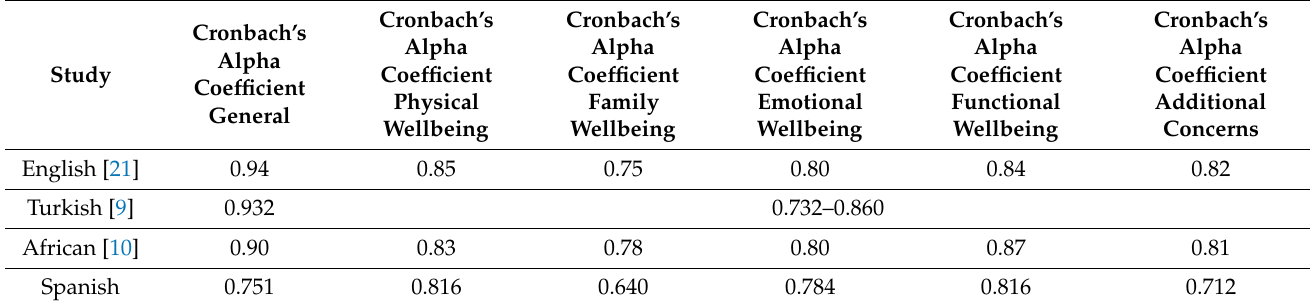
Table 5. Reliability comparison.